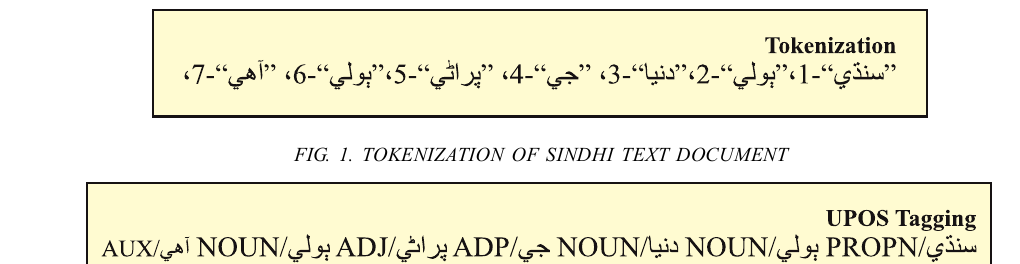
FIG. 2. ANNOTATION OF SINDHI TEXT DOCUMENT WITH UNIVERSAL POS TAG SET